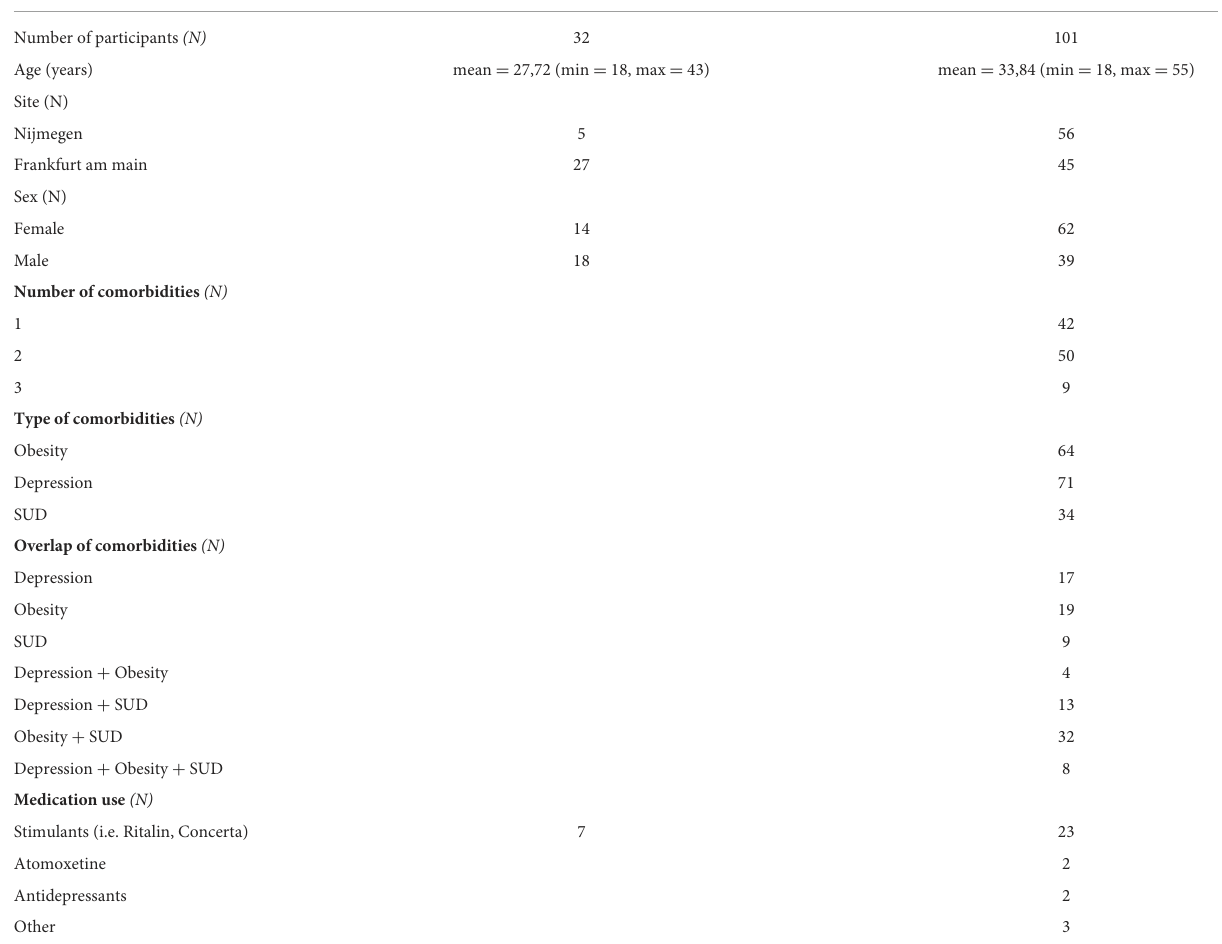
TABLE 1 Participant